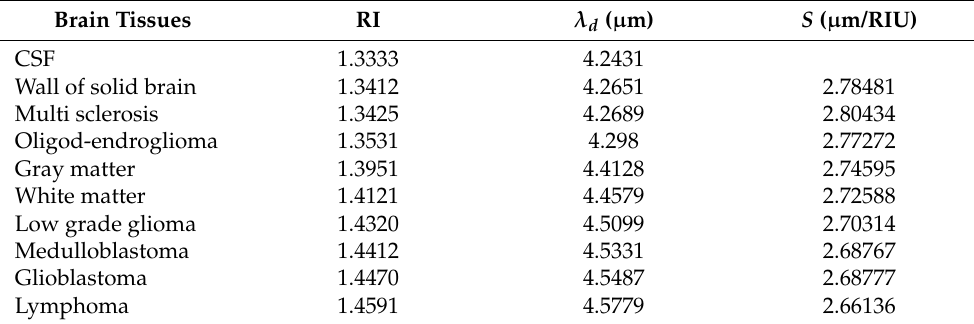
Table 1. The refractive index (RI), central wavelength of defect mode ( λ d ) and senstivity ( S ) of the proposed design with d 4 = 15 dd and η = 0.8 under the influence of different samples containing brain tissues at θ = 0 ◦